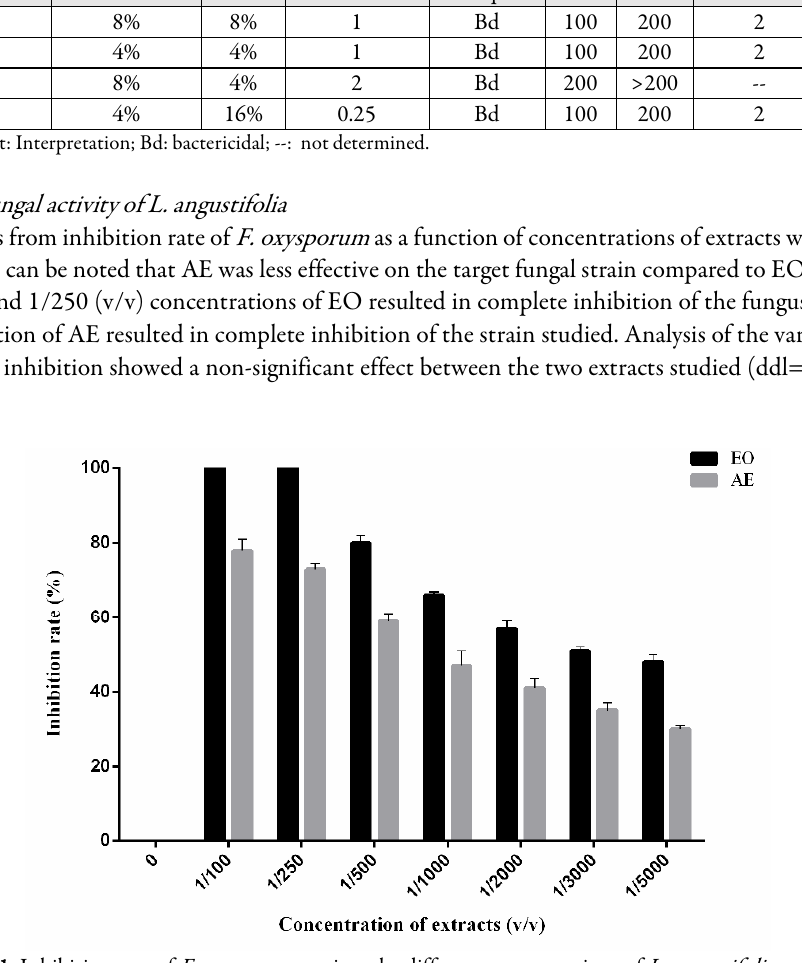
Table 6. Antimicrobial parameters of L. angustifolia extracts and their interpretation Essential oil Aqueous extract Strains